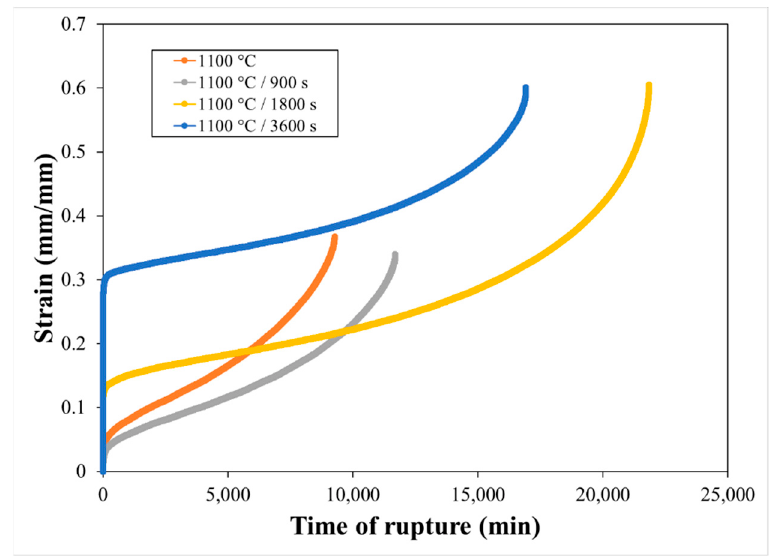
Figure 14. Effect of annealing time on the creep rupture behavior of 253 MA ASS at 700 °C and a load of 150 MPa.